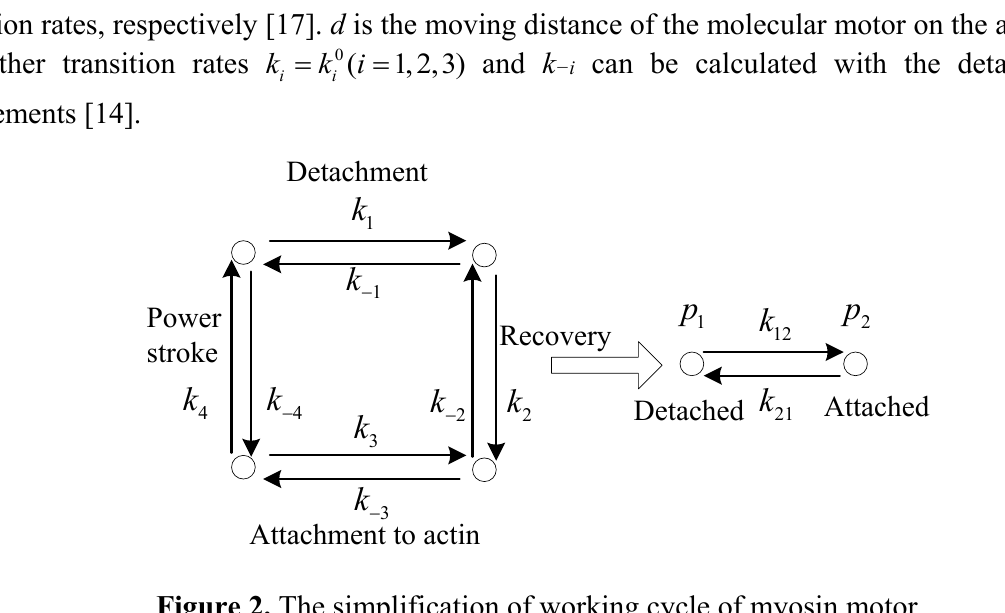
Figure 2. The simplification of working cycle of myosin